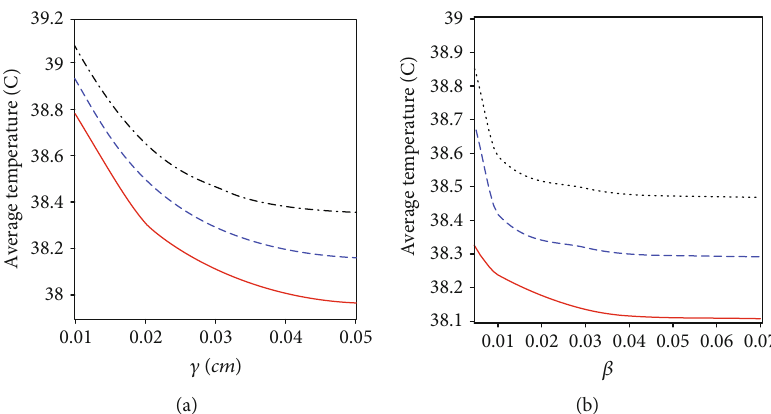
Figure 6: The e ff ect of γ and β on the average temperature on the elliptic cross-section at three wave